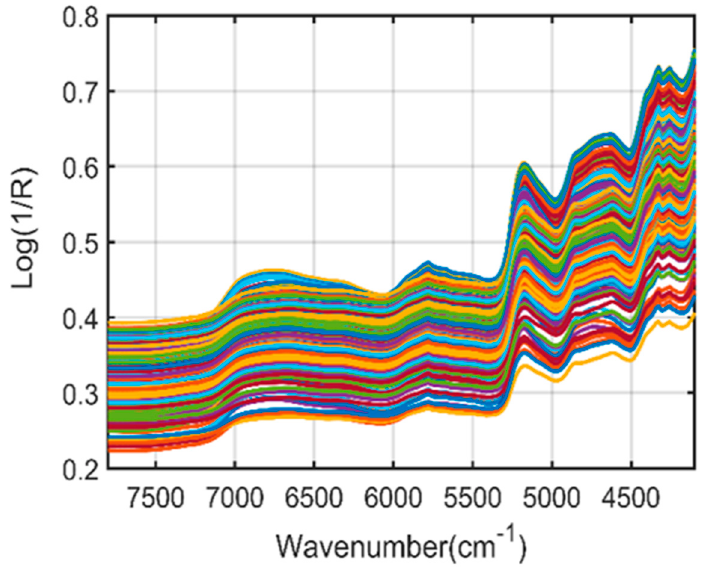
Figure 3. Fourier-transform near-infrared (FT − NIR) raw spectra of A. thaliana powder samples.